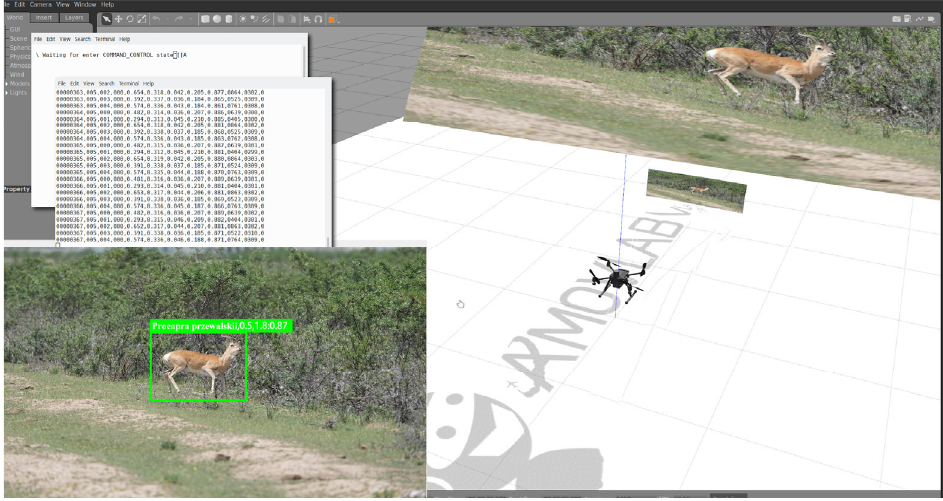
Figure 10. Verification scenario for the tracking algorithm of Procapra przewalskii based on the Prometheus simulation system.